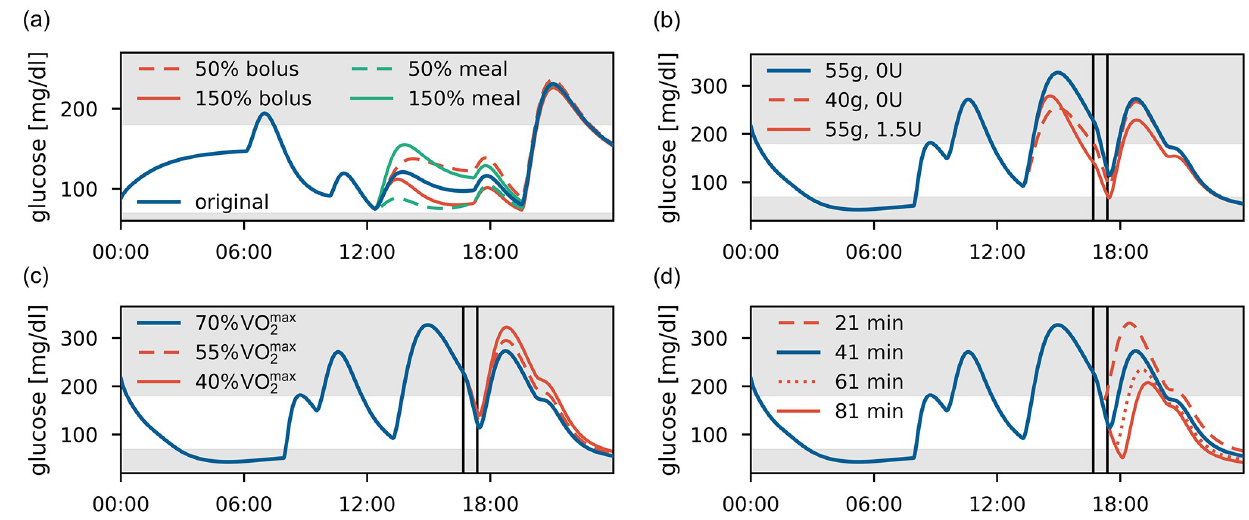
Fig 6. Replay simulations. (a) Participant #3, day 1. Variations in meal size and insulin dose at lunch to 50% and 150% of their original size. (b)-(d) Participant #5, day 2, with a PA session marked by vertical lines. The original glucose trajectory is shown in blue. (b) Meal or bolus adjustment for pre-PA meal. (c) Alterations in PA intensity from 70% VO max to 55% and 40% VO max . (d) Alterations in PA duration from 41 min to 21, 61 and 81 min, with the 2 2 post-exercise meal following directly after the session.